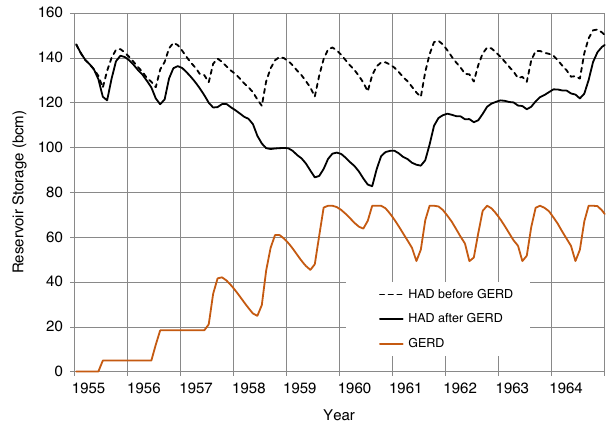
Fig. 3 GERD fi lling effects beginning with a historically wet 10-year sequence. Storage volumes for the GERD and HAD are shown.